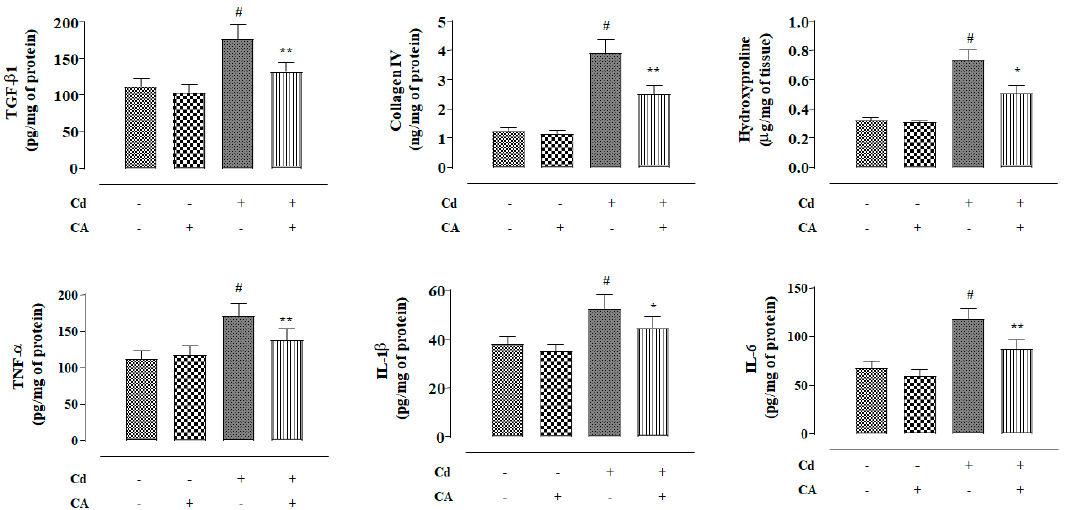
Figure 8. The effects of CdCl 2 and/or CA on fibrotic and inflammatory markers in mouse kidneys in vivo. Data are represented as the mean ± SD, n = 6. # Values significantly ( p < 0.01) differed from the vehicle-treated group. * Values significantly ( p < 0.05) differed from only the CdCl 2 -treated group. ** Values significantly ( p < 0.01) differed from only the CdCl 2 -treated group.